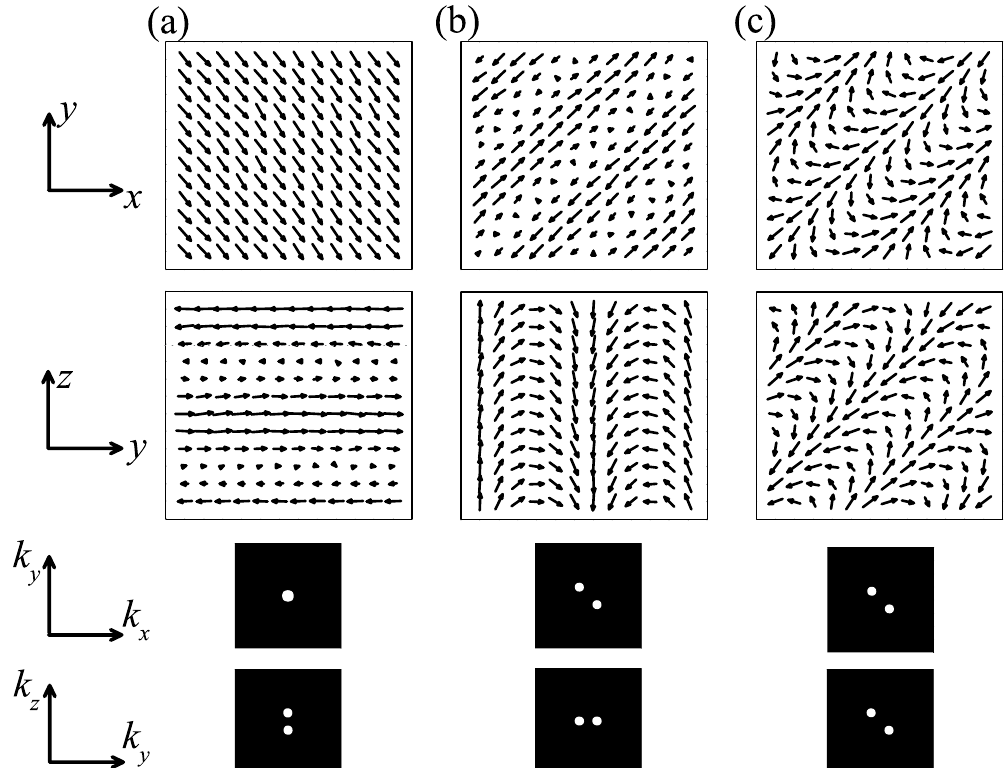
Figure 2. A plot of the spin configurations projected on the xy plane (up) and projected on the yz plane (middle). At the bottom of each figure are the plots of the Bragg intensity from Fourier transition which shows the sets of helix vectors. The parameters are ( a ) ( α , β ) = (0.866, 0.577), ( b ) ( α , β ) = (1.155, 0.816), and ( c ) ( α , β ) = (1, 1) at T =